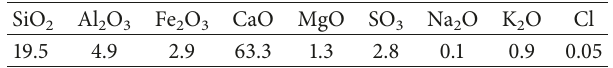
Table 4: Fly ash chemical composition